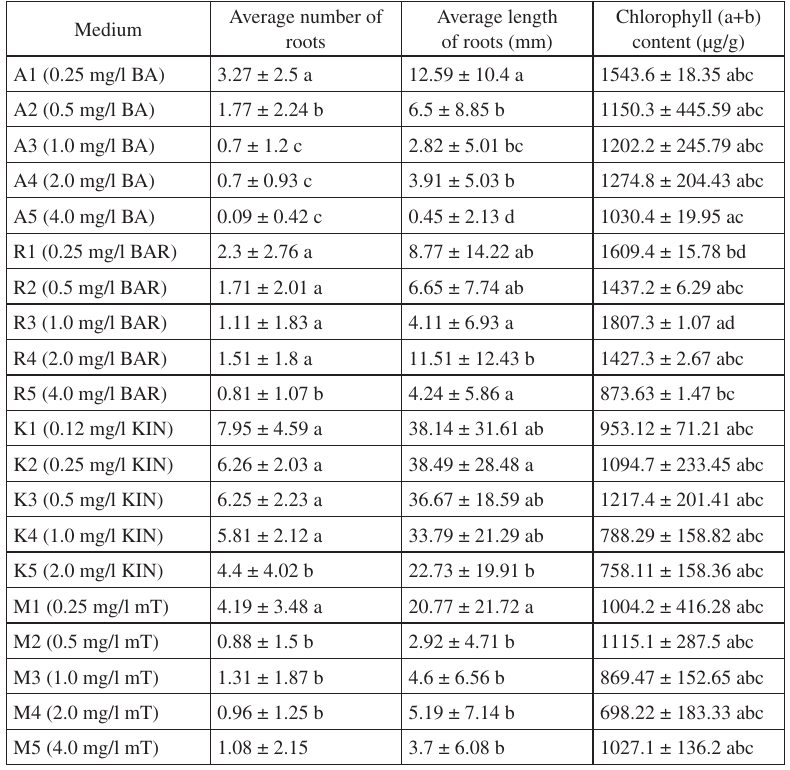
Table 2. Number and length of roots, chlorophyll (a+b) contents of in vitro Nidularium ‘Kertész Jubileum’ plants from different kind of medium Average number of Medium roots